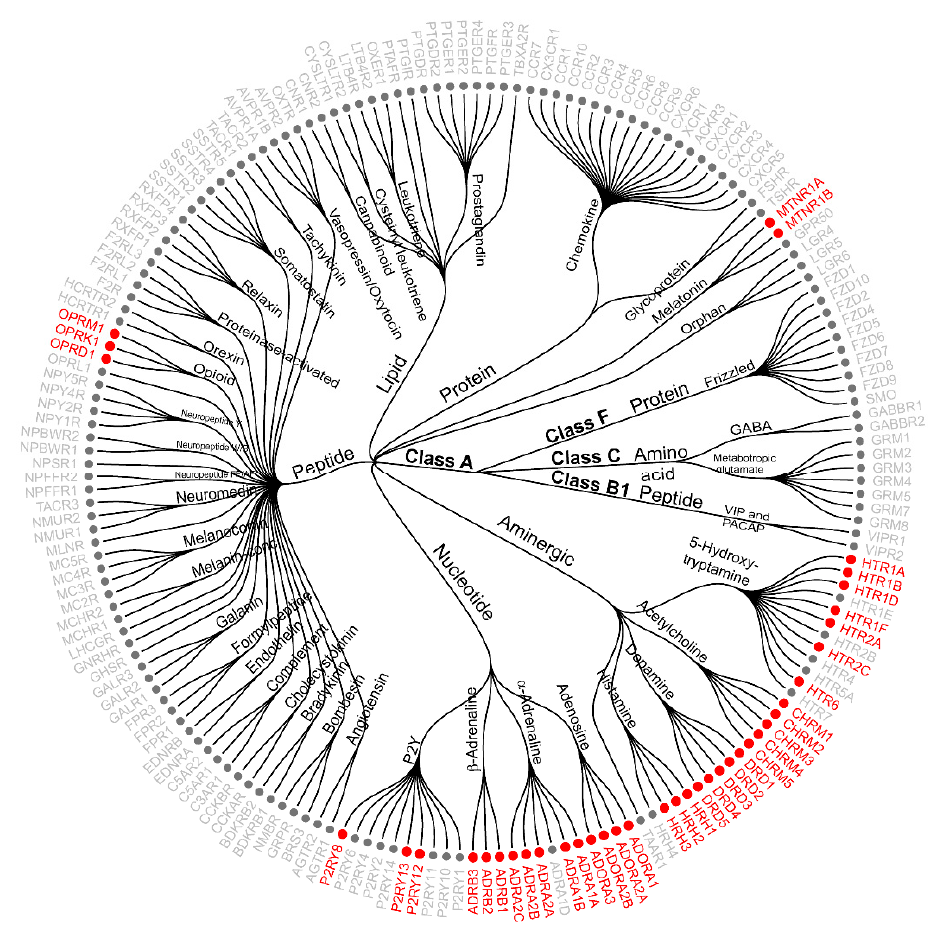
Figure 8. NanoBRET GPCR ligand-engagement assays facilitated by lead fluorescent tracers. A circular dendrogram showing GPCRs classified according to their family and class types [1]. NanoBRET ligand-engagement assays for the GPCRs highlighted in red were facilitated by lead fluorescent tracers developed in this study. Details on these assays including, the fluorescent tracers associated with each assay as well as tracers’ binding affinity and structures are included in Figures S12 and S13.